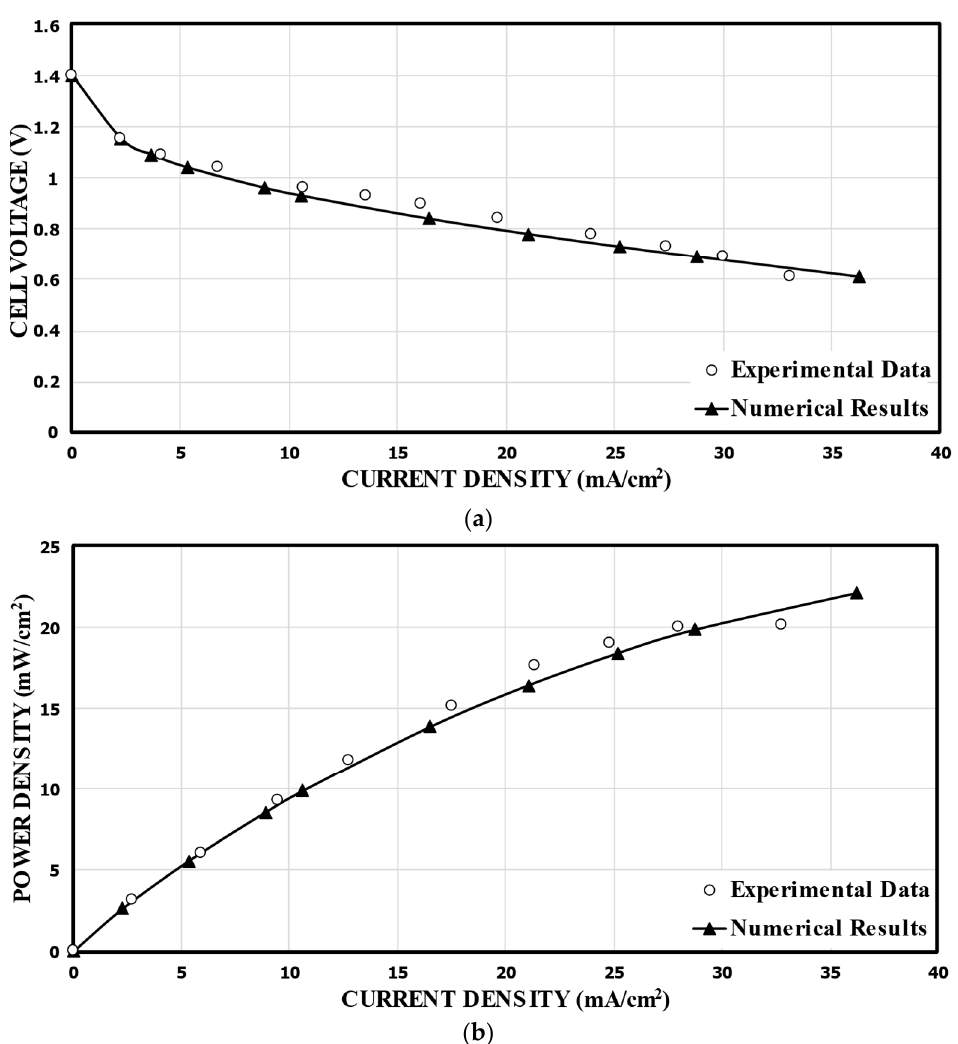
Figure 4. Validation of the predicted performance curves using experimental data of Montesinos et al. [17]. ( a ).Cell voltage; ( b ). Power density.